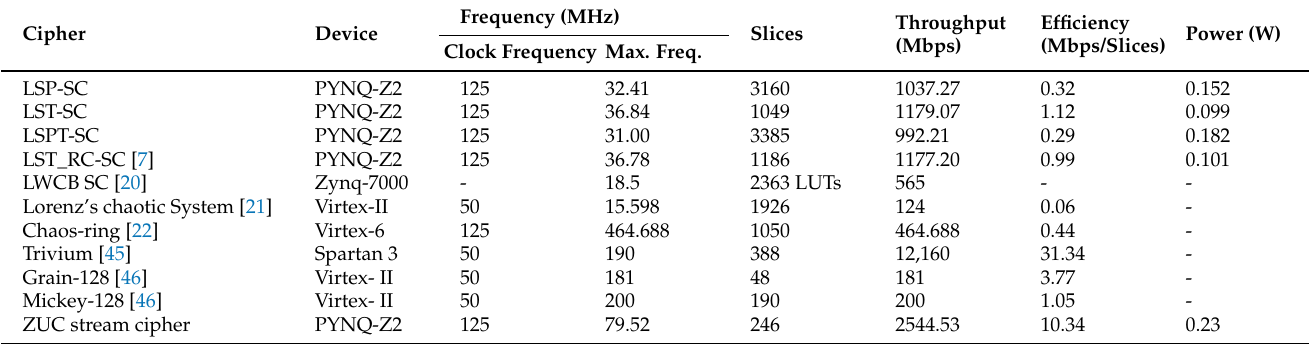
Table 13. Comparison of hardware metrics usage among various chaotic and non-chaotic